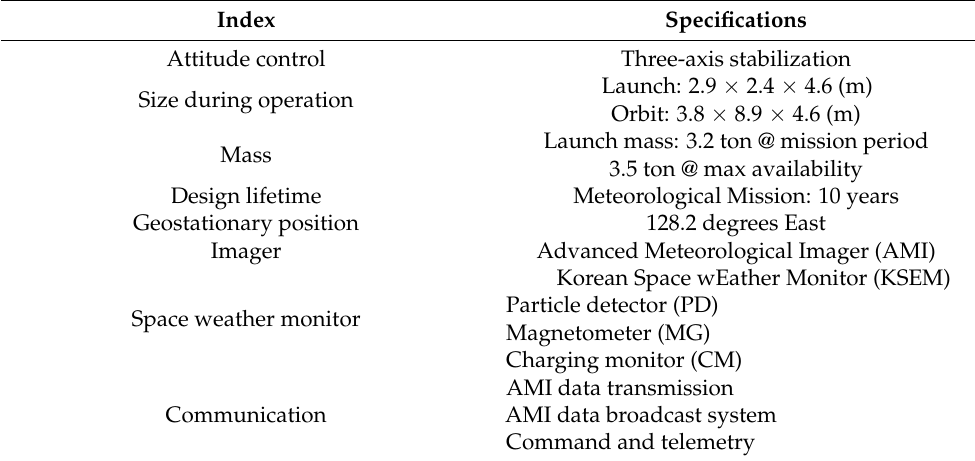
Figure 1. Illustration of Geo-Kompsat-2A (GK2A). Table 1. Major Specifications of GK2A.